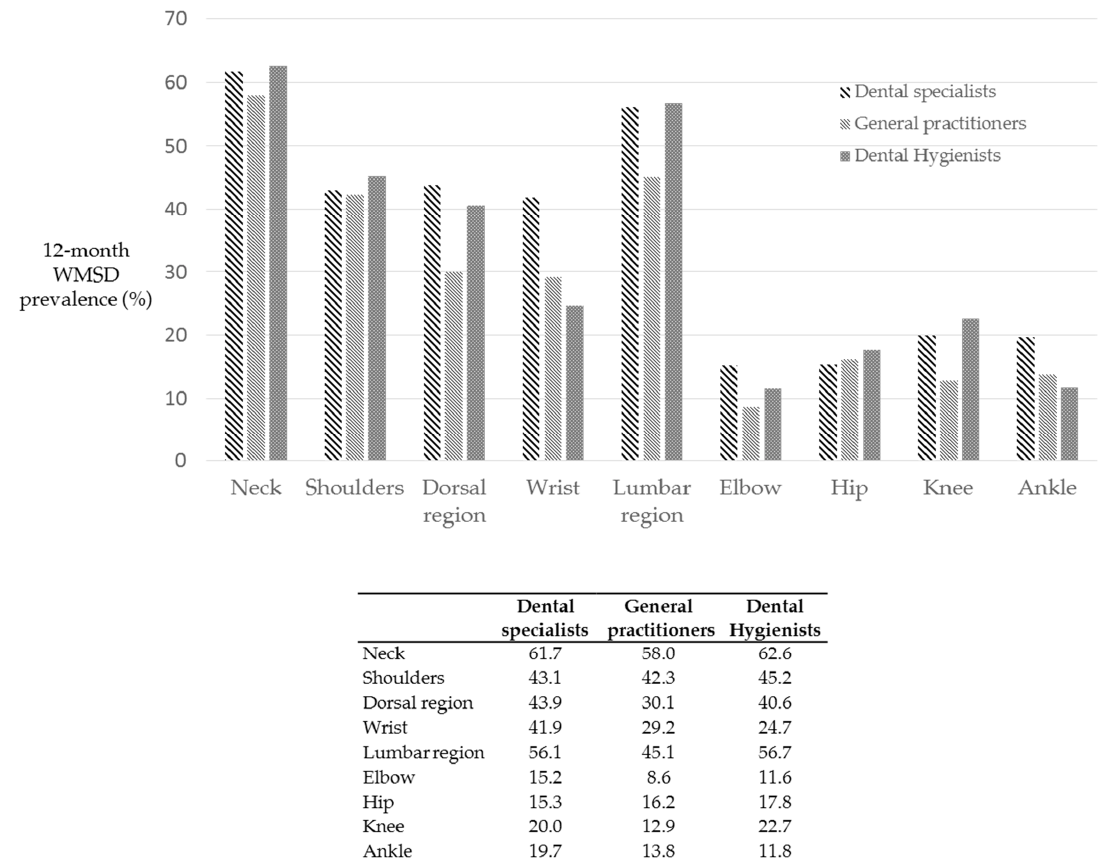
Figure 5. Distribution of WMSD, expressed as percentages, in relation to odontological activity. Dental specialists group included endodontists (29.2%), restorative dentists (23.1%), prosthodontists (12.3%), periodontists (10.2%), oral surgeons (8.6%), orthodontists (8.7%) and implantologists (7.5%). No significant differences were observed when considering dental occupation ( p > 0.05).